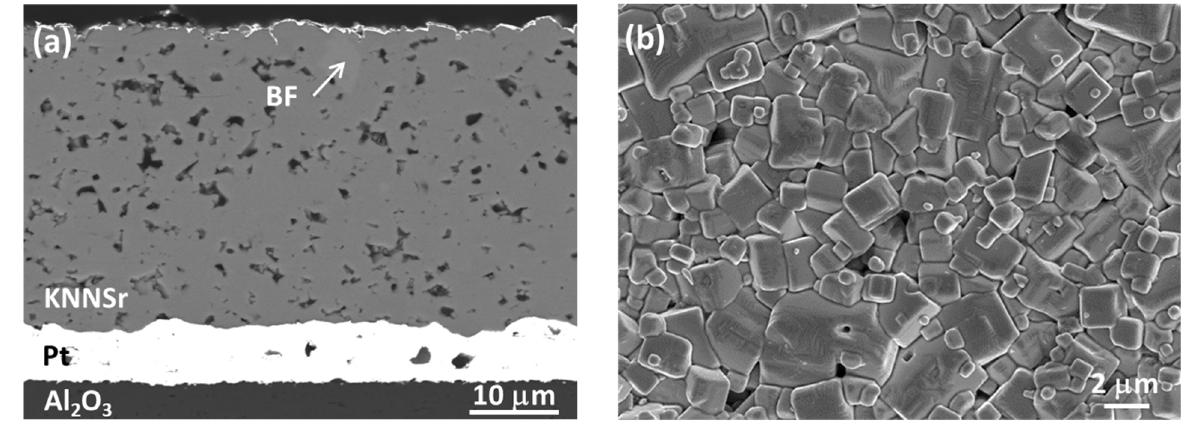
Figure A1. Polished cross-section ( a ) and surface ( b ) SEM images of the KNNSr-AO. The KNNSr thick film is well adhered to the substrate. We have not detected any secondary phase at the Al 2 O 3 /Pt/KNNSr interfaces meaning that the KNNSr and the sub- strate are chemically compatible phases under selected sintering conditions. The as-deposited layers (3 passes) had a thickness of 57 μ m. After sintering the KNNSr-AO had thicknesses of 39 μ m, meaning that the KNNSr shrunk during the sinter- ing in thickness direction for 31%. The relative density, calculated from the SEM images, was 90 ± 1%. The microstructures of the sample were relatively homogeneous and we have not observed any macro defects, such as cracks. By EDXS analysis we conformed that the ma- trix phase corresponds to the perovskite phase with (K+Na)/Nb ratio of ~1. We detected also a TB, bright phase. The grain size of KNNSr-AO ranged from ~0.4 μ m to ~6 μ m.